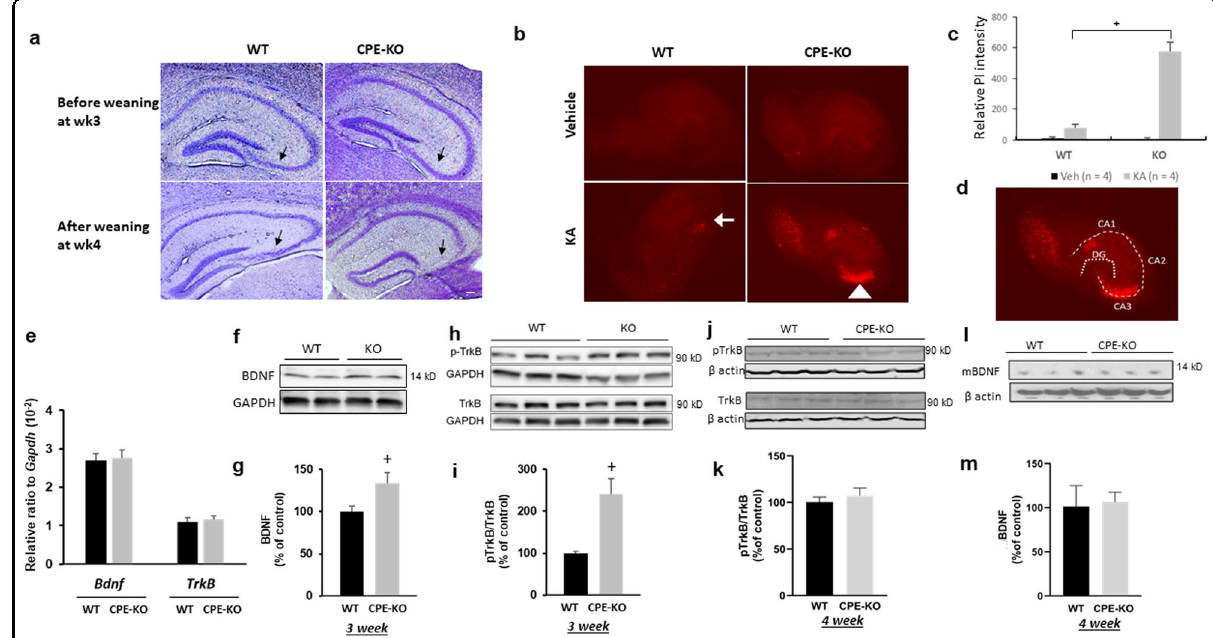
Fig. 1 The effect of weaning stress and kainic acid on neurodegeneration of hippocampal CA3 region and BDNF/TrkB expression in hippocampus of WT and CPE-KO mice. ( a ) Nissl staining of coronal anterior hippocampus of WT and CPE-KO mice. CPE-KO mice displayed signi fi cant hippocampal CA3 degeneration after the weaning stress paradigm, but not before weaning. Sale bar = 100 μ m. b Images of propidium iodide staining and ( c ) bar graphs representing the effect of kainic acid (KA) on mouse organotypic hippocampal slice culture. Note the severe cell death in the CA3 region (see arrowhead in ( b )) in the CPE-KO mice compared to WT mice (see arrow). n = 4, Wilcoxon non-parametric comparison. + p = 0.02857 for KA-treated KO compared with KA-treated WT. Veh: Vehicle. KA: Kainic acid. WT: wild type. d Schematic illustration of CA1, CA2, CA3, and dentate gyrus(DG) of the hippocampus. e mRNA levels of BDNF and TrkB in the hippocampus from 3-week-old CPE-KO mice. There was no difference in expression between CPE-KO and WT mice. WT n = 6, CPE-KO n = 8. The mRNA expression level for each sample was normalized to Gapdh . f Representative western blot and ( g ) quanti fi cation showing levels of BDNF protein in the hippocampus of 3-week-old CPE-KO and WT mice. n = 10, Student ’ s t test, + p = 0.03314. Values are mean ± SEM. h Representative western blot and ( i ) quanti fi cation showing levels of phospho-TrkB and TrkB proteins in the hippocampus of 3-week-old CPE-KO and WT mice. n = 5. Student ’ s t test, + p = 0.01669, Values are mean ± SEM. j Representative Western blot and ( k ) quanti fi cation showing levels of phospho-TrkB and TrkB proteins in the hippocampus of 4-week-old CPE-KO and WT mice. n = 3 mice. Student ’ s t test, p = 0.531, values are mean ± SEM. l Representative Western blot and ( m ) quanti fi cation showing levels of mBDNF protein in the hippocampus of 4-week-old CPE-KO and WT mice. n = 3 mice, Student ’ s t test, p = 0.853, values are mean ±